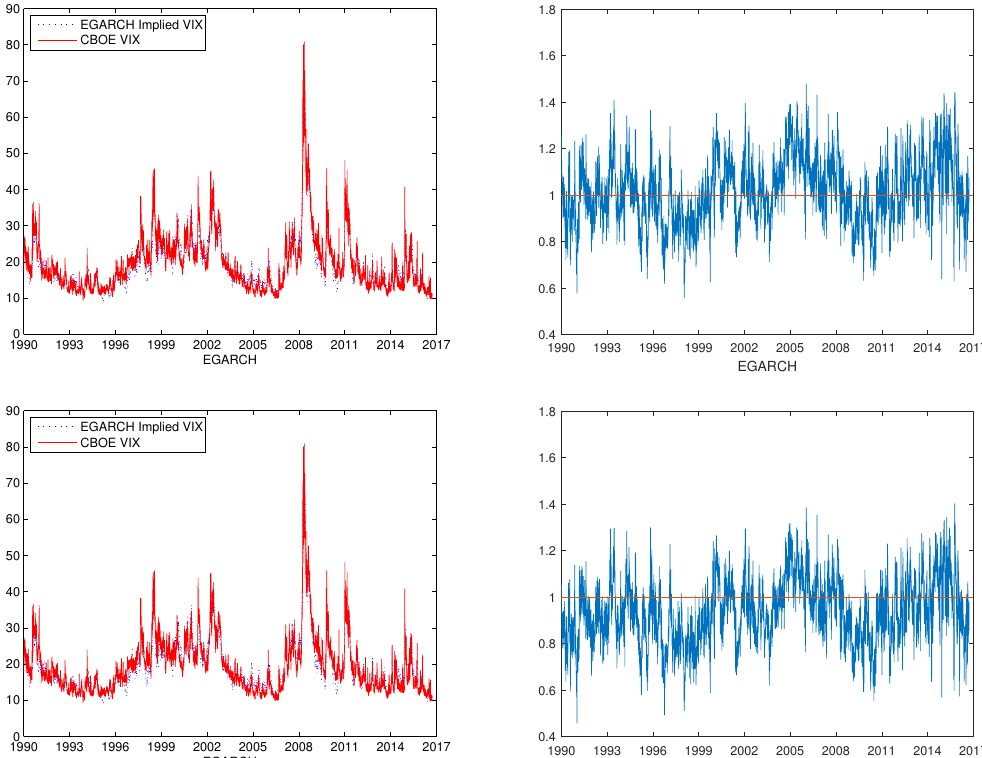
Figure 8. Comparison between CBOE VIX and implied VIX of the EGARCH(1,1) model using both returns and VIX data with the upper panel showing the result under the mLRNVR and the lower panel showing the result under the LRNVR. The left panels show the index values of CBOE VIX and implied VIX and the right panels show the ratio of the implied VIX to CBOE VIX and a horizontal line at 1 for